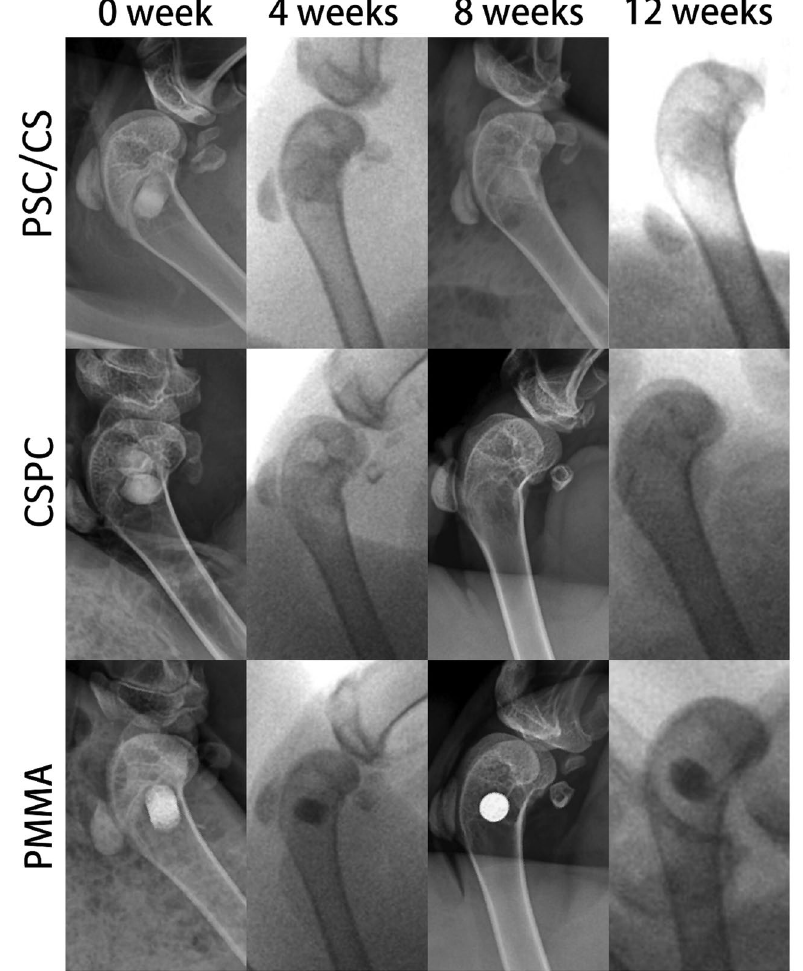
Figure 3. Radiographic images of defect site of three